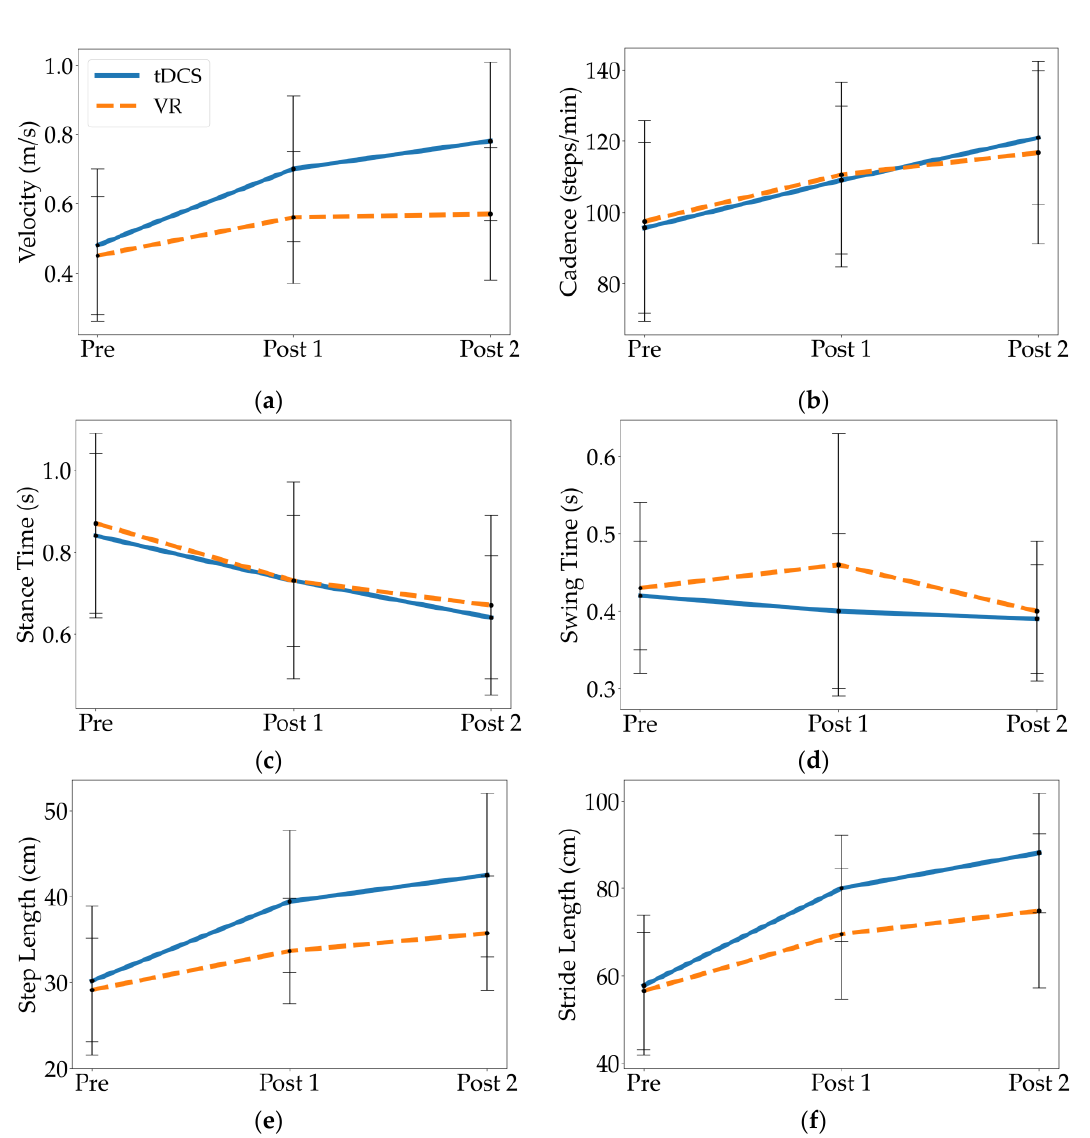
Figure 3. Mean and standard deviation of spatiotemporal parameters at Pre, Post 1, and Post 2 for the tDCS and VR groups, including ( a ) velocity, ( b ) cadence, ( c ) stance time, ( d ) swing time, ( e ) step length, and ( f ) stride length.